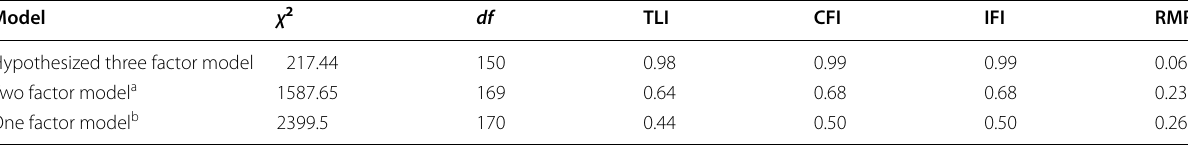
n 300, All models are compared with the full measurement model =